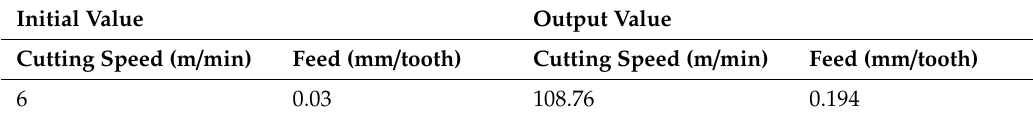
Figure 10. Machining parameters ( left ) and results ( right ) for slot2 operation of the case study. Table 9. Initial and optimum parameters of slot2 Table 9. Initial and optimum parameters of slot2 milling.